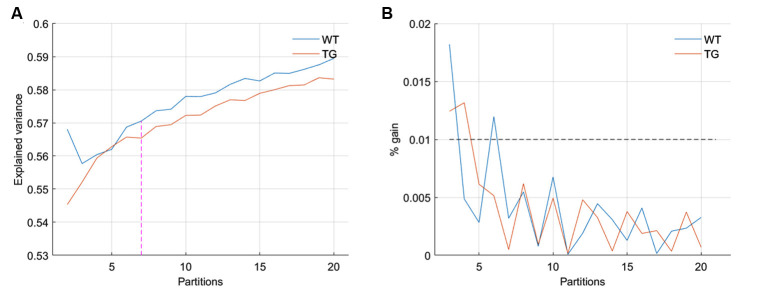
(A) Across-subject variance explained as a function of the number of clusters in the partition of group-level image-series without global signal regression. The elbow point here beyond which the explained variance saturates is found to be at the partition with seven clusters. (B) The fraction of gain in the explained variance as the number of clusters in the partition increase from k to k + 1, as a function of partitions. The elbow point of seven clusters is the first instance for both groups at which the fractional gain in explained variance falls below 10%.